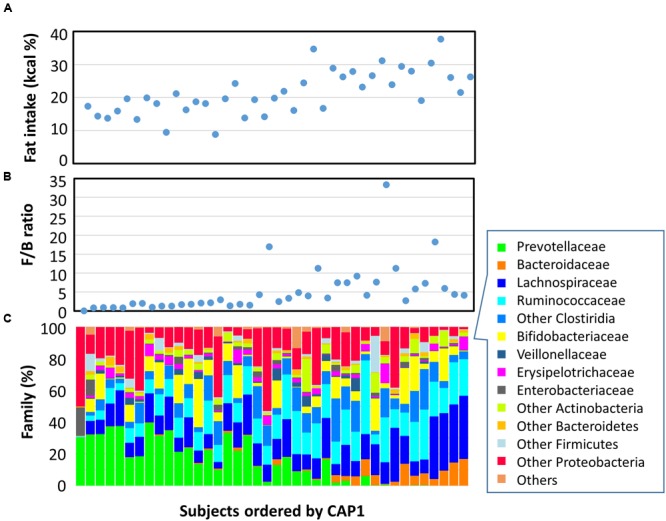
Fecal bacterial composition and correlation with dietary fat intake. Plots representing data from 40 Leyte children are ordered by CAP1 score on the x-axis, and by their fat energy intake ratio (A), fecal Firmicutes-to-Bacteroidetes (F/B) ratio (B), and fecal bacterial family composition (C) on the y-axis.